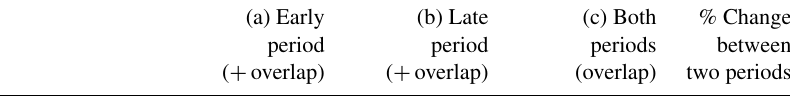
Table 2. Columns (a)–(c): total number of MSD grid cells (percent change from original in parentheses) with different values of criteria used to define an MSD for the early period (1981–2000), late period (2001–2020), and both periods. Changes in the total number of MSD pixels between the periods are shown in column